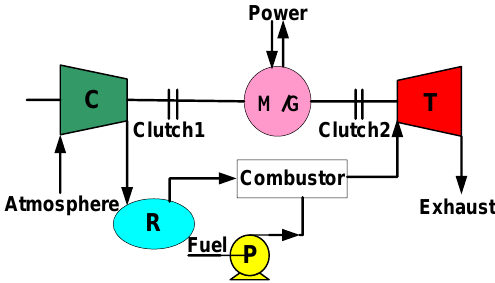
Figure 5. Schematic diagram of CAES system (C—Compressor, G-T—Gas turbine, M/G—Motor/ Generator, P—Pump, R—Reservoir).